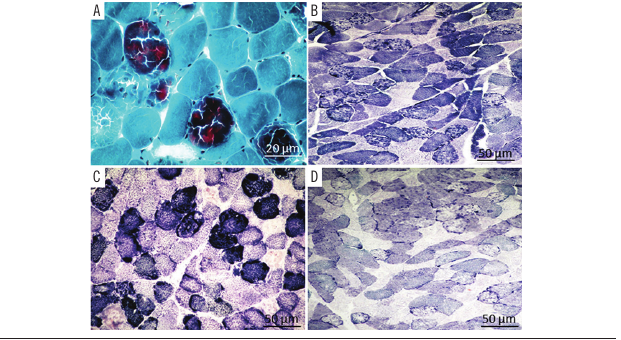
figurE 5 − Necrotic fibers in modified Gomori trichrome (A) and NADH-TR (C). Note some similarity with ragged red fibers but with macrophages and acid phosphatase (not shown) positivity instead; NADH-TR can far resemble mitochondrial accumulation. In B and D lobulated fibers usually found in some dystrophies are shown; they can look like mitochondrial accumulations but they presented with the same aspect in all oxidative stains (NADH-TR, SDH and COX)